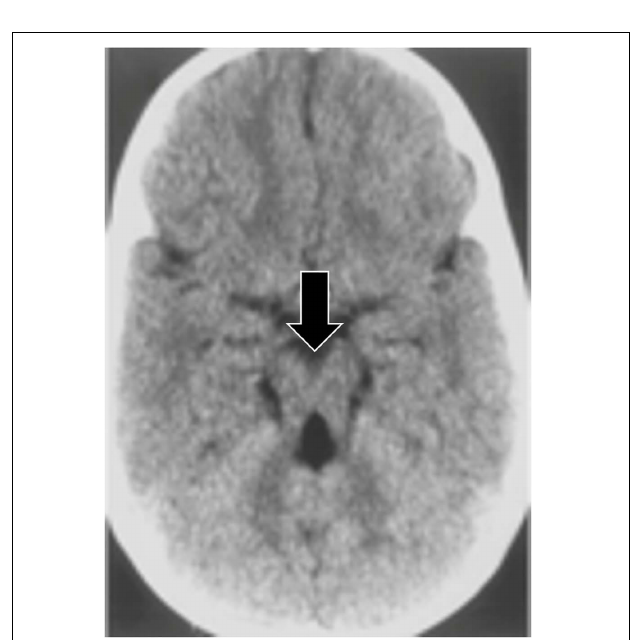
FIGURE 5 | An axial CT image demonstrating the molar tooth sign, a pattern associated with Joubert syndrome. Lack of normal decussation of the fiber tracts of the superior cerebellar peduncles and the pyramids results in thickened and horizontally oriented superior cerebellar peduncles (McGraw, 2003; Romani et al., 2013). Along with the decreased anteroposterior dimension of the brainstem resulting from the absence of crossing fibers, and a deeper interpeduncular fossa (McGraw, 2003), these lead to the classic molar tooth appearance (from Gleeson et al.,